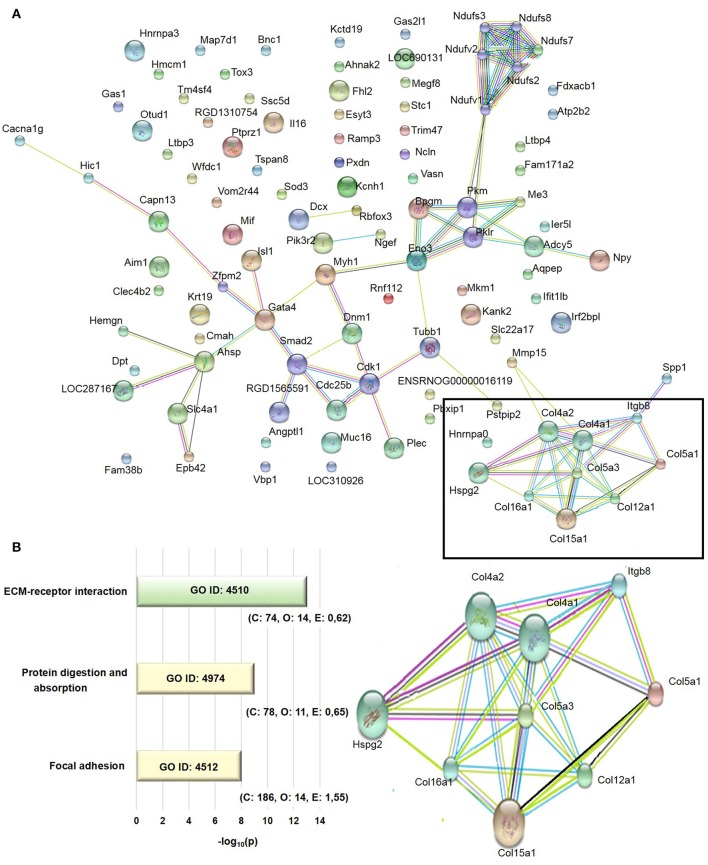
Transcriptome analysis of periepididymal adipose tissue. (A) Identification of network interactions of differentially expressed genes between C and AGE-albumin-treated animals. Bioinformatic analysis of RNA-seq data were performed by DeSeq2 Version 3.5, GO, GSEA and compared to STRING 9.0, using an interaction score 0.400 - medium confidence. Signal p-value > 0.1, fold change <0.04, micro-RNA and pseudogenes were excluded. (B) The extracelullar matrix-receptor interaction (ECM-receptor interaction), protein digestion and absorption and focal adhesion were obtained by gene ontology (GO) enrichment analysis. Number of reference genes in the category (C), number of genes in the set and also in the category (O) and the expected number (E) in the category were observed after p-value cutoff of <0.01 and fold-change >0.4 adjusted. Adjusted p (AdjP) were converted in –log10 with variation between 8 and 13.